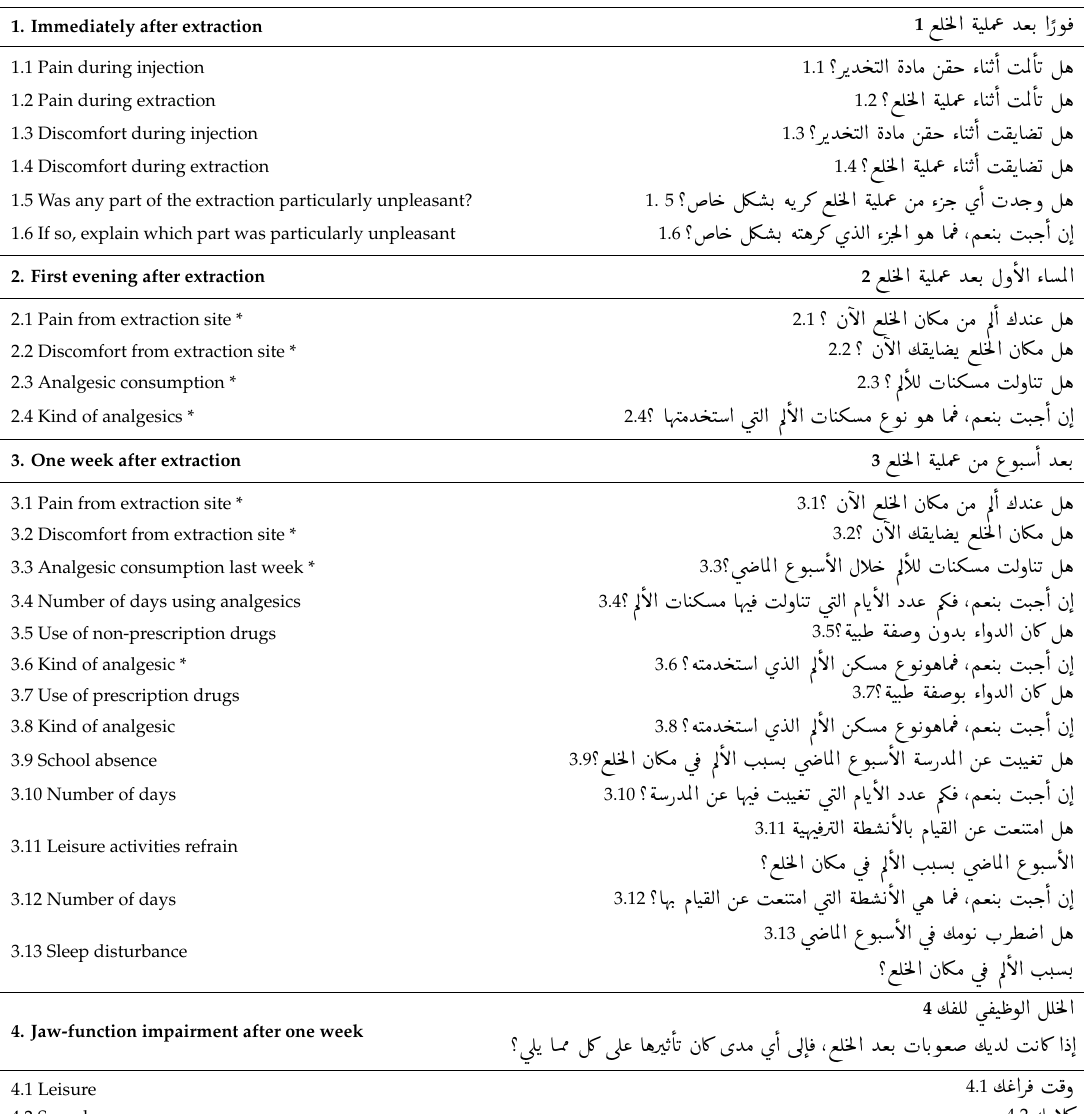
Table 1. A self-reported questionnaire comprising 33 items that assessed pain, discomfort, analgesic consumption, daily activities, and jaw-function